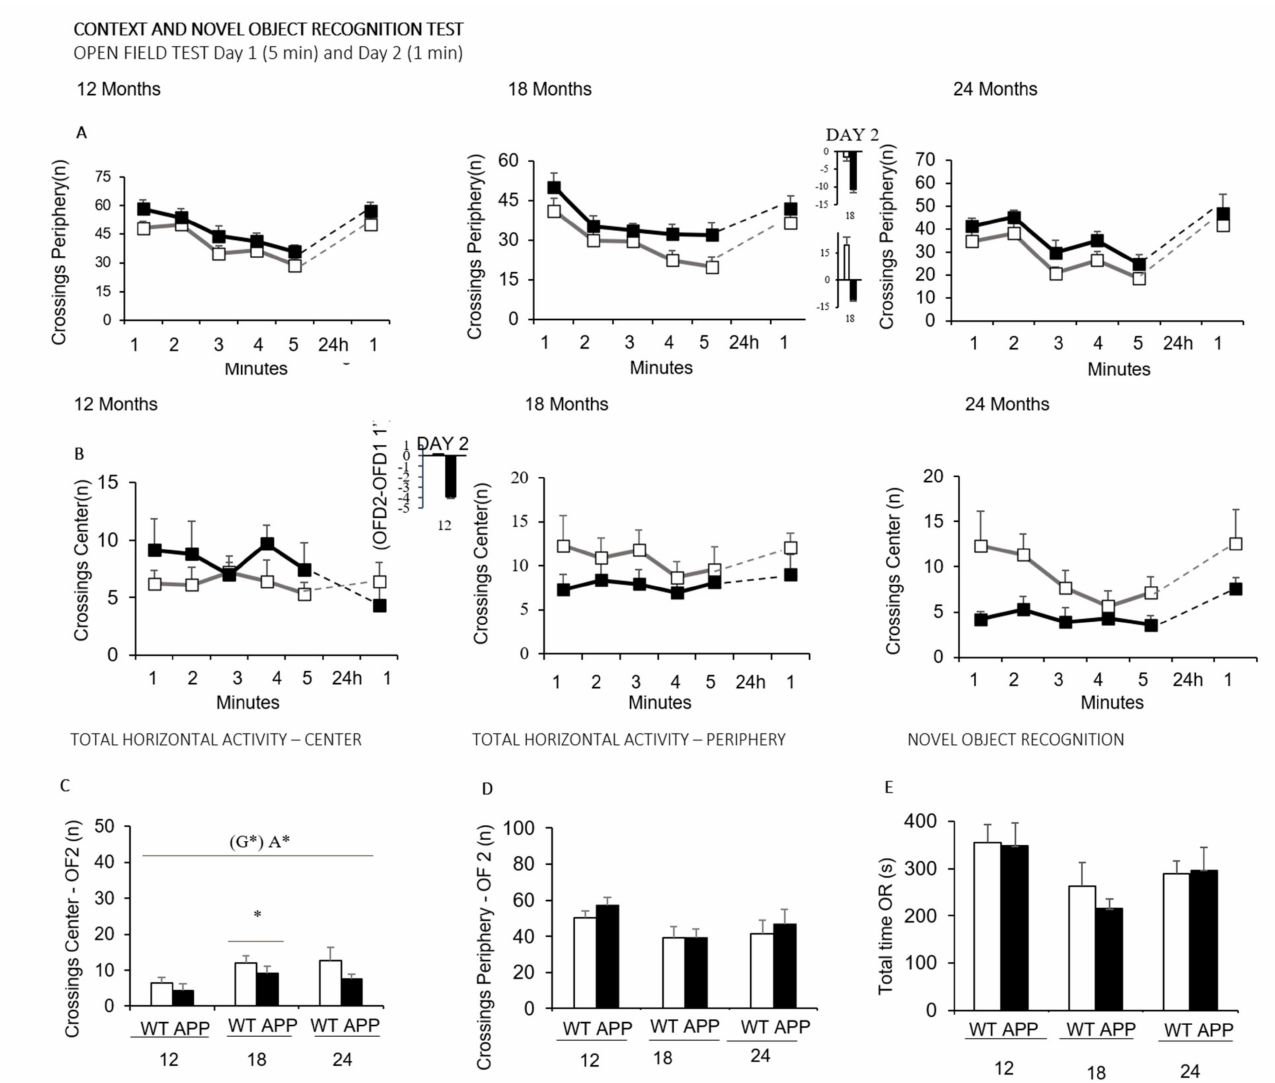
Figure 3. Context and novel object recognition tasks. Data are expressed by mean ± SEM. Time course of the horizontal activity (number of crossings) exhibited in the periphery ( A ) and the center ( B ) of the open-field test on Day 1 and 2, in 12-, 18- and 24-month-old WT (white squares) and APP23 (black squares). ( C ) Total horizontal activity (number of crossings) in the periphery on Day 2, in 12-, 18- and 24-month-old WT (white bars) and APP23 mice (black bars), ( D ) Total horizontal activity (number of crossings) in the center on Day 2, in 12-, 18- and 24-month-old WT (white bars) and APP23 mice (black bars). ( E ) Total time of exploration of the novel object (seconds) in the object recognition test in 12-, 18- and 24-month-old WT (white bars) and APP23 mice (black bars). Analysis of variance 2 × 3: Effects of genotype (G), Age (A), * p < 0.05. Post-hoc analysis: * p < 0.05 vs. 12 months of